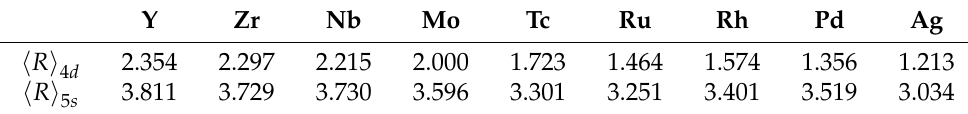
Table A3. Average radial distance of 4 d and 5 s Electrons